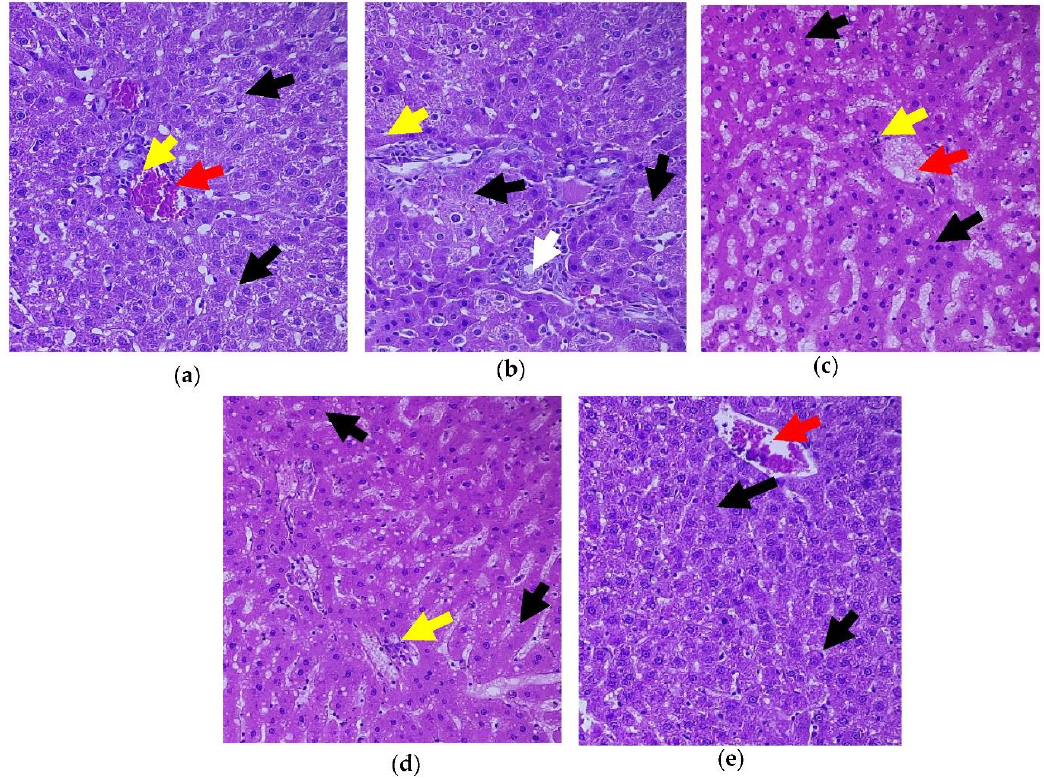
Figure 9. Histopathology of hepatic tissue displaying the effect of C. papaya. ( a ) Control rats; ( b ) T2DM rats presented degenerated hepatocytes (black arrow) while matched with the control; ( c ) C. papaya -treated T2DM rats manifested improved hepatocytes with hepatic bands; ( d ) metformin-treated T2DM rats exhibited the restored structure of hepatocytes; ( e ) C. papaya -treated control rats. Yellow arrow — centrilobular inflammation; white arrow — bile duct; red arrow — blood vessels.